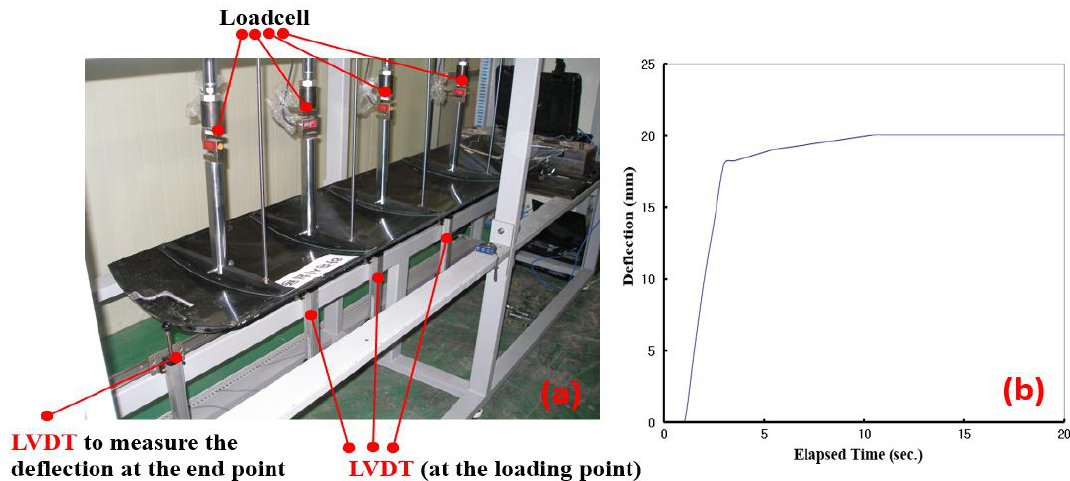
Figure 11. Real deflection test; ( a ) Test set-up, ( b ) Result of deflection test.